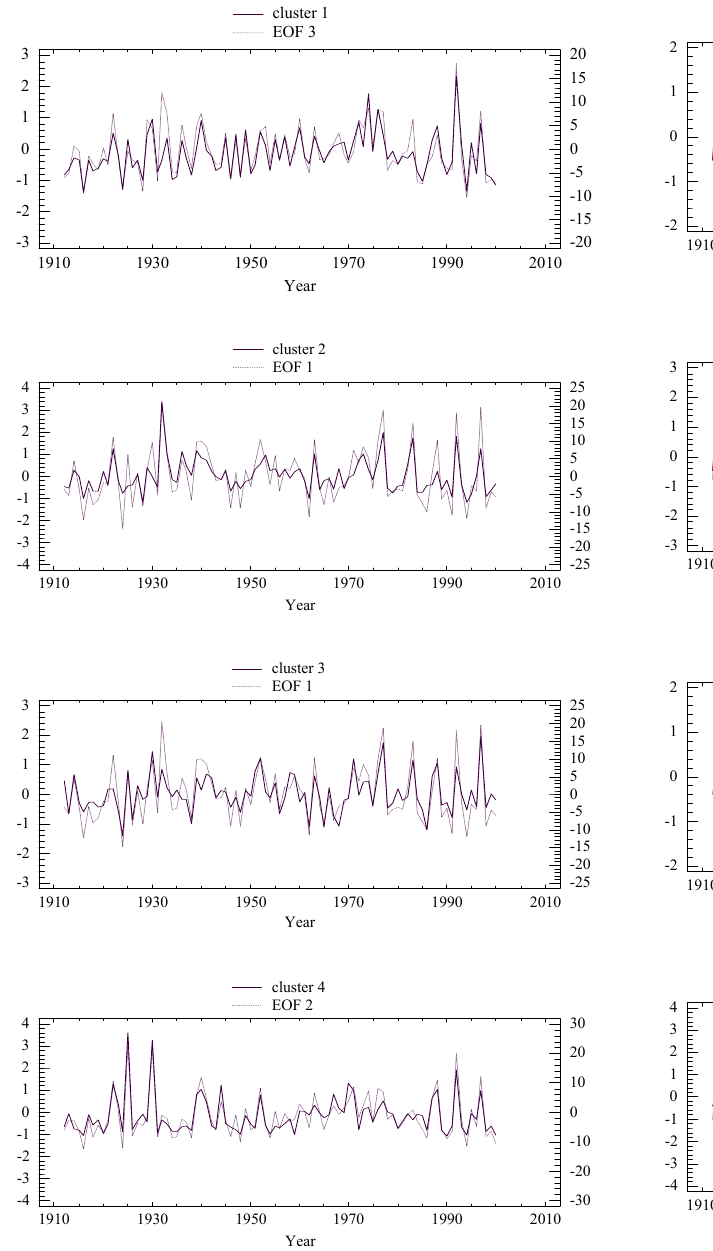
Fig. 13. As Fig. 10, for autumn.